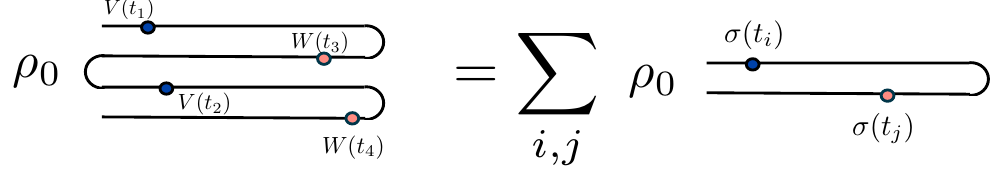
Figure 7 . At leading order in large OTO four-point functions de(cid:12)ned on a four-contour reduce N to a sum of two-point functions of (cid:27) ( t ). They can therefore be calculated from the e(cid:11)ective action of the hydrodynamic (cid:12)eld (cid:27) on a CTP